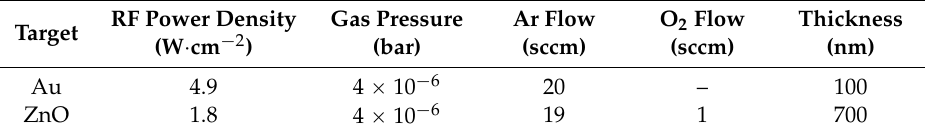
Table 2. Deposition conditions and average thickness of sputtered Au and ZnO thin films.